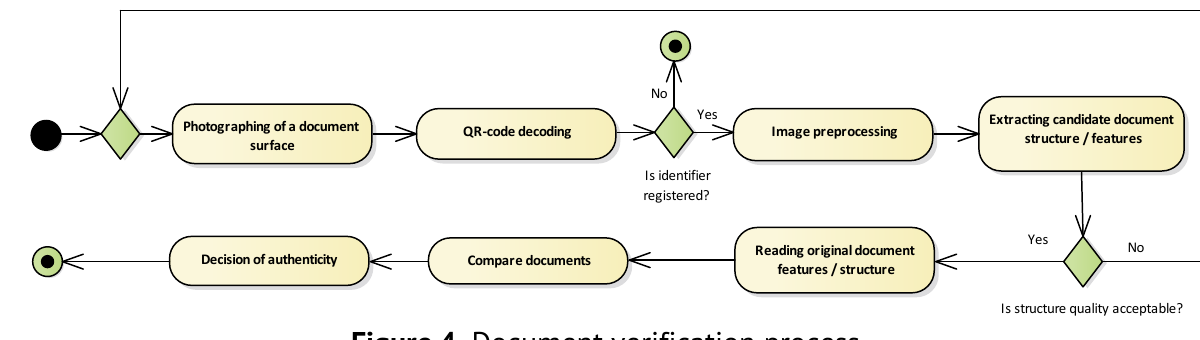
Figure 4. Document verification